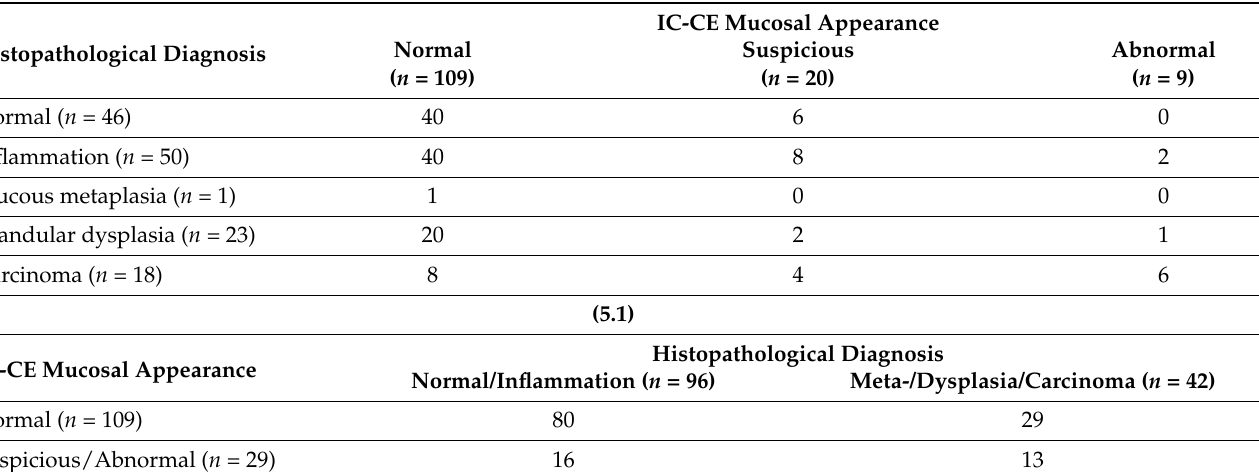
Table 5. Most severe histopathological diagnosis of biopsy sites and categories of gastric mucosal assessment of dogs identified in 138 endoscopic still images taken during IC-CE. 5.1. 2 × 2 table for histopathological diagnosis and IC-CE mucosal